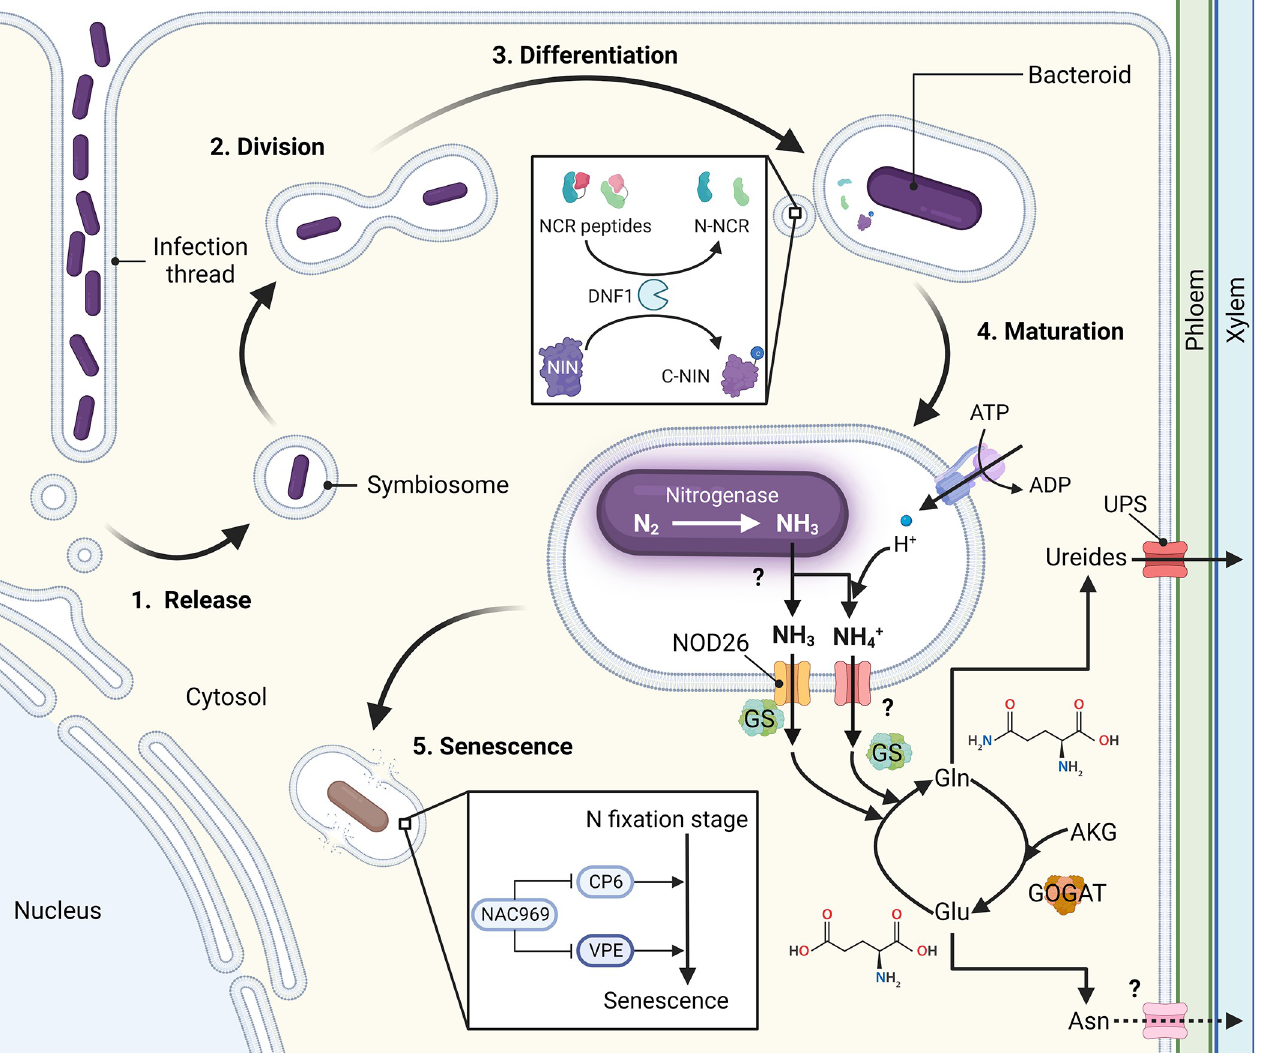
Fig 4. Creating an environment for nitrogen fixation and nitrogen delivery. Once the infection thread reaches the nodule primordium, infection threads release droplets into the cell containing bacteria, always surrounded by a plant-derived membrane. These structures, the so-called symbiosomes, are organelle- like. Symbiosomes can continue to divide, and the bacteria can differentiate into bacteroids. The DNF1-cleaved N-NCR is delivered into the symbiosome via membrane vesicle trafficking and induces bacteroid differentiation. DNF1 also proteolytically cleaves the NIN protein and generates a C-NIN, activating genes involved in terminal differentiation and nitrogen fixation. The nitrogenase enzyme complex in rhizobia converts N 2 into ammonia that is released from the bacteroid via diffusion or unknown channels. The H+-ATPases on the symbiosome membrane create an acidic peribacteroid space, which traps ammonium by protonating ammonia and producing ammonium cations. Ammonium cations are exported into the cytoplasm of plant cells and then assimilated into Gln and Glu by GS and by GOGAT, transferring the amide group from Gln to AKG. Depending on legume species and nodule types, Gln and Glu are converted into Asn or ureides for long-distance transport through the xylem. In the end, the nodule undergoes senescence and bacteroids lyse. Different CPs are highly expressed in nodules at the senescence stage, especially a papain peptidase (CP6) and a VPE, which are controlled by a transcription factor NAC969. Created with BioRender.com. AKG, α -ketoglutarate; Asn, Asparagine; C-NIN, C-terminal NIN peptide fragment; CP, cysteine proteinase; Gln, glutamine; Glu, glutamate; GOGAT, glutamate synthase; GS, glutamine synthetase; NAC, NAM/ATAF/CUC; NAC969, NAC-encoding 969; NIN, NODULE